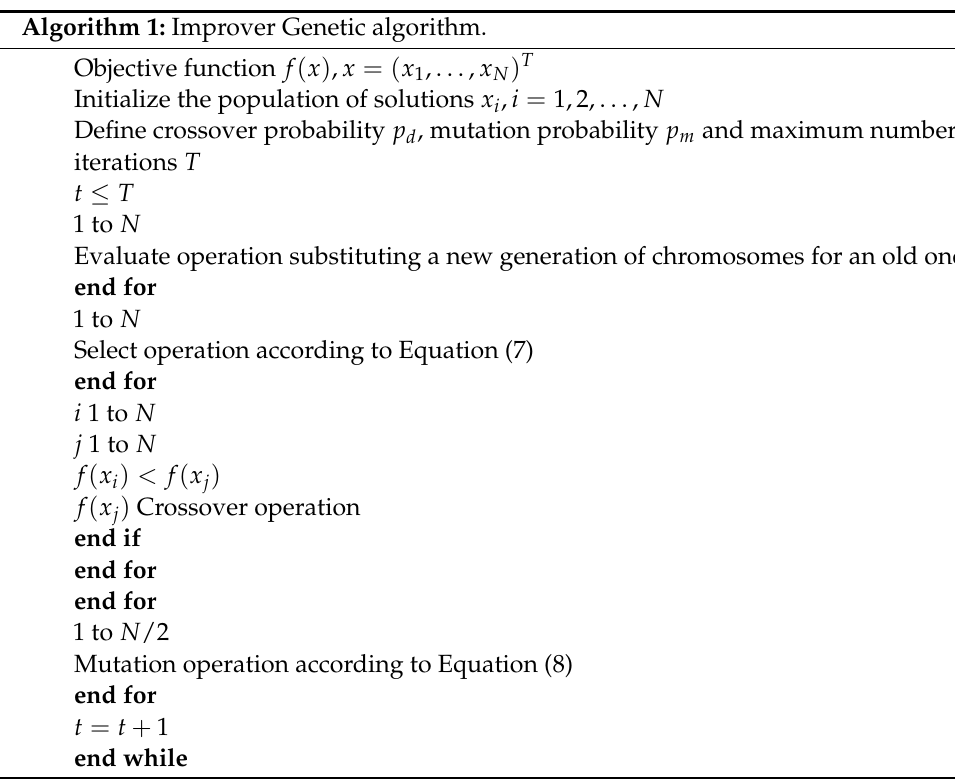
Algorithm 1: Improver Genetic